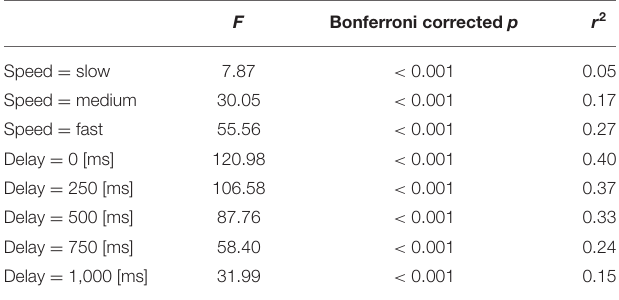
TABLE 2 | Simple main effects of delay and speed on heaviness